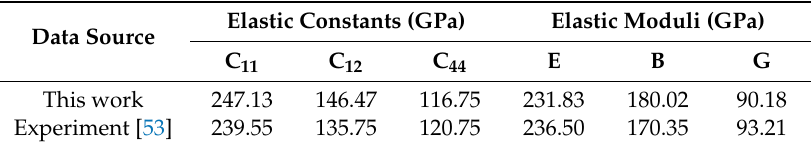
Table 1. The elastic constants and moduli of α -Fe.